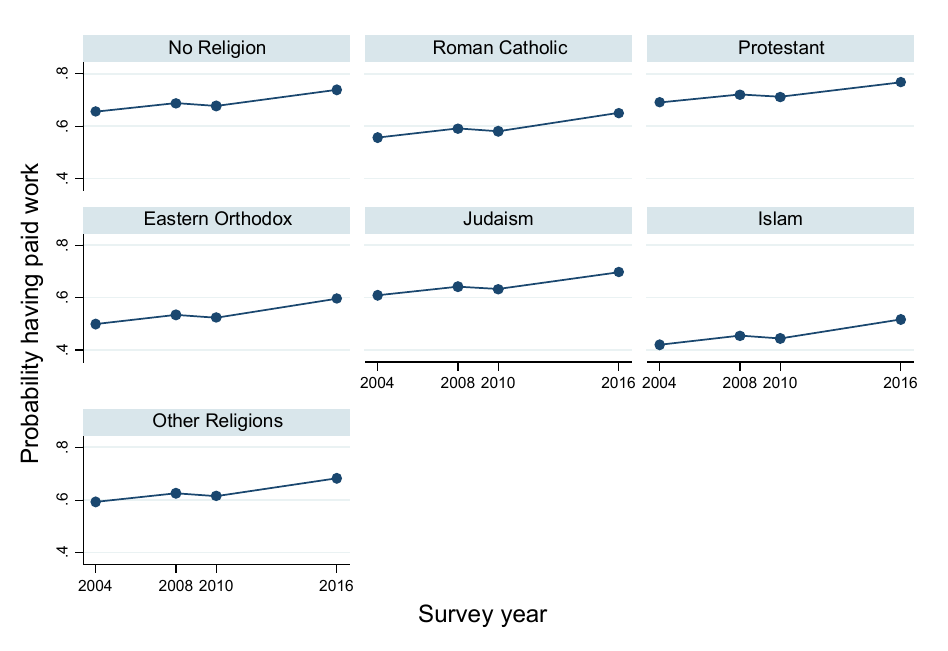
Figure 2 : Religious groups and their employment rates across ESS rounds